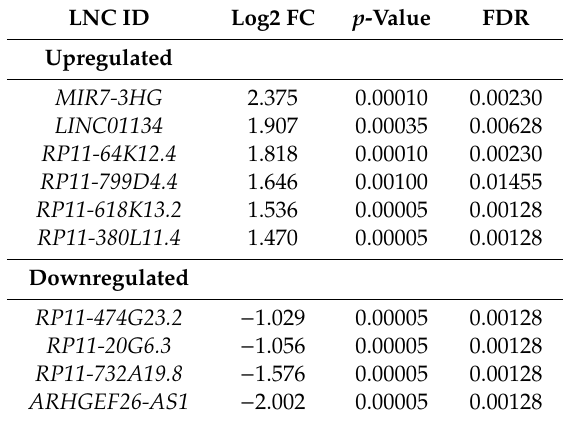
Table 4. Top 10 upregulated and downregulated lncRNAs in ILK-siRNA(2) vs. C-siRNA.